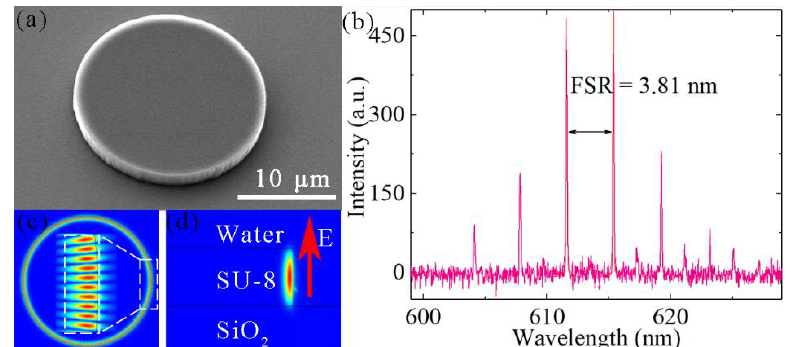
Figure 3. ( a ) SEM image of the microdisk. The scale bar is 10 µ m. ( b ) Laser spectra of a microdisk dipped in water. The free spectral range (FSR) was 3.81 nm. ( c ) and ( d ) Field distributions of whispering-gallery modes (WGMs) in fundamental-order-radial mode with transverse electric (TE) polarization in the top view and side view. The direction indicated by the red arrow was the direction of electric field propagation. Finite element method (FEM) simulations were performed with the same parameters for the experimental